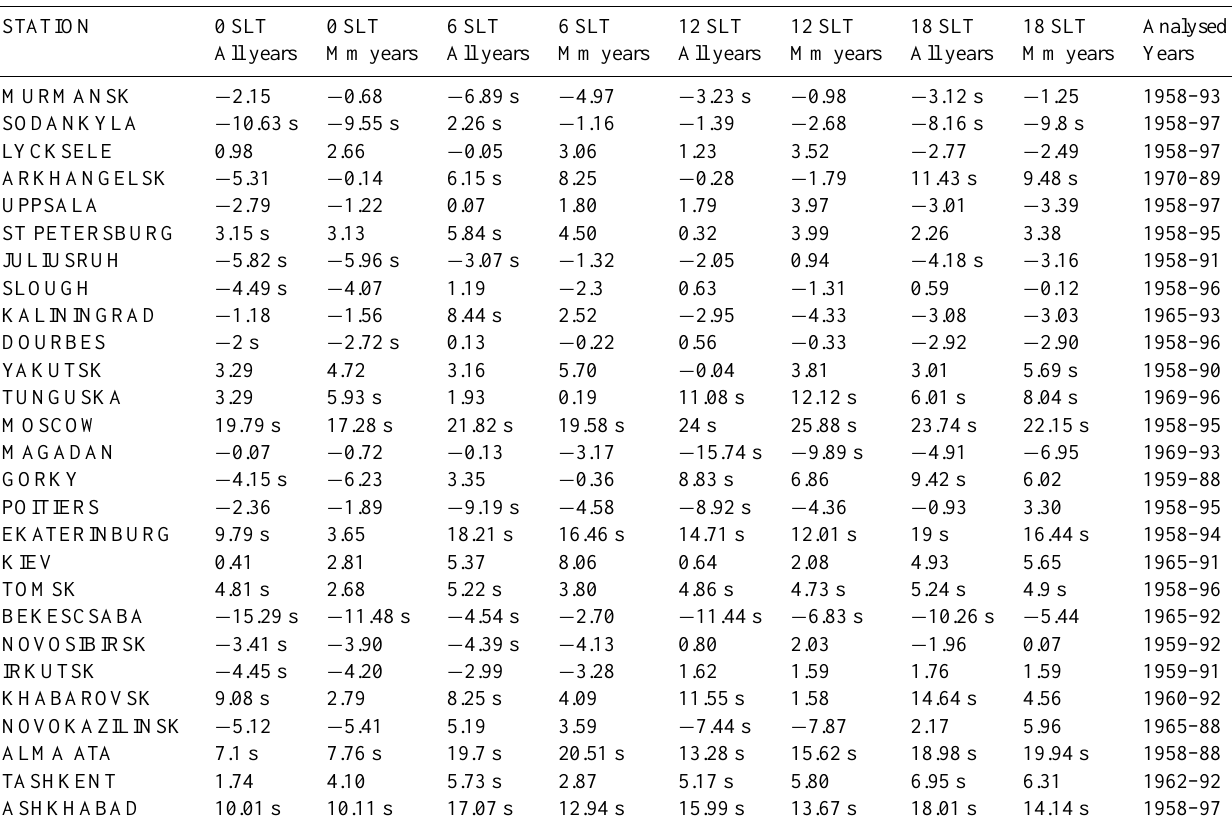
Table 5. Calculated annual mean slope K (in 10 − 4 units) for the whole period with hm F2 observations available on a particular ionosonde station. Regression of hm F2 with R 12 + Ap 12 (Model 2) , and all years as well as years around solar maximum and minimum (Mm years) are used to obtain hm F2 linear trends. Significant trends at a confidence level of 95% are denoted by an “s” after the